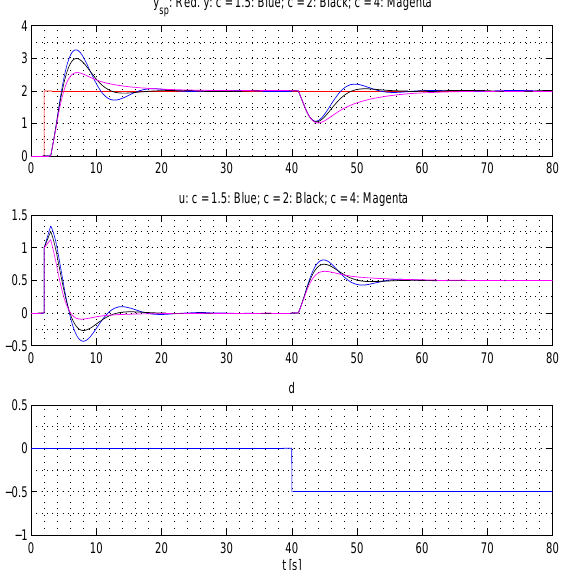
Figure 15: Simulations of control systems for an “in- tegrator with time-delay” process with Sko- gestad controller tuning with c s = 1 . 5, c s = 2, and c s = 4.